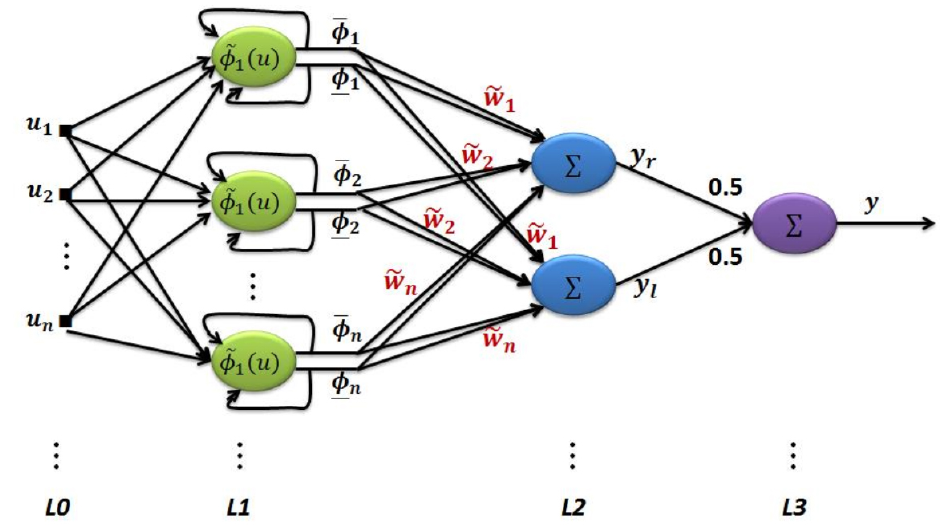
Figure 2. Recurrent type-2 fuzzy